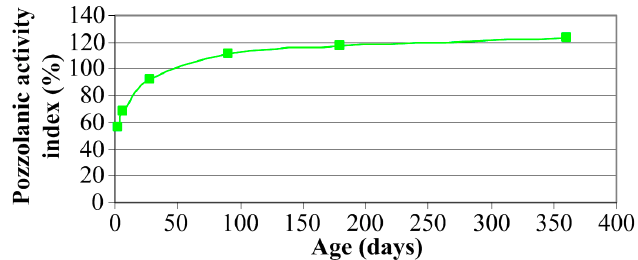
Figure 11. Pozzolanic activity index vs. age of mortar.